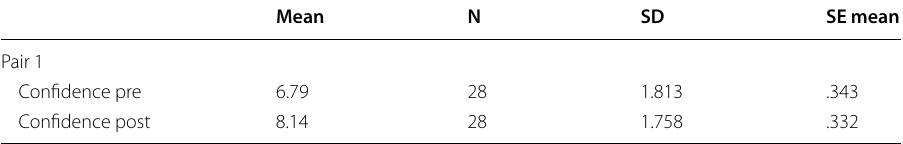
Table 3 Paired samples statistics: confidence. Source: SPSS 23.0 output Mean N SD SE mean Pair